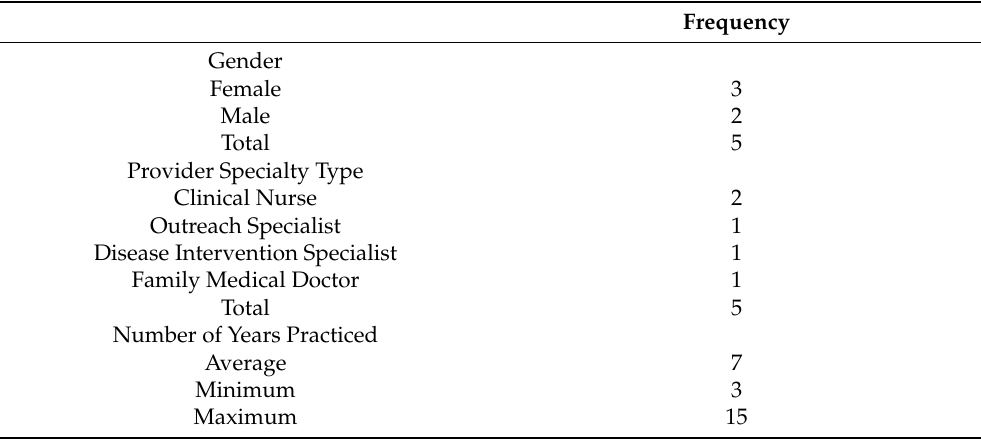
Table 2. Maternal Healthcare Provider